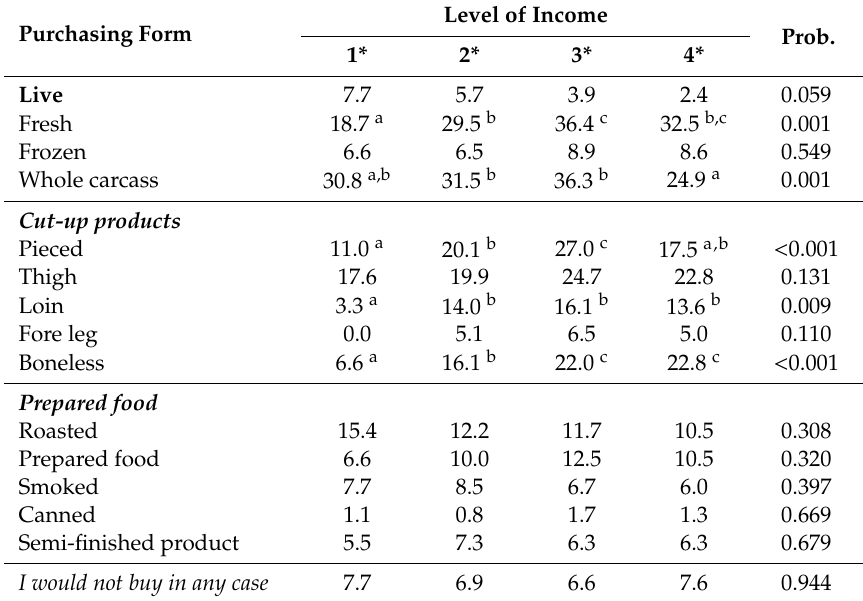
Table 6. E ff ect of purchase forms on the respondents’ attitude depending on the income with multiple response